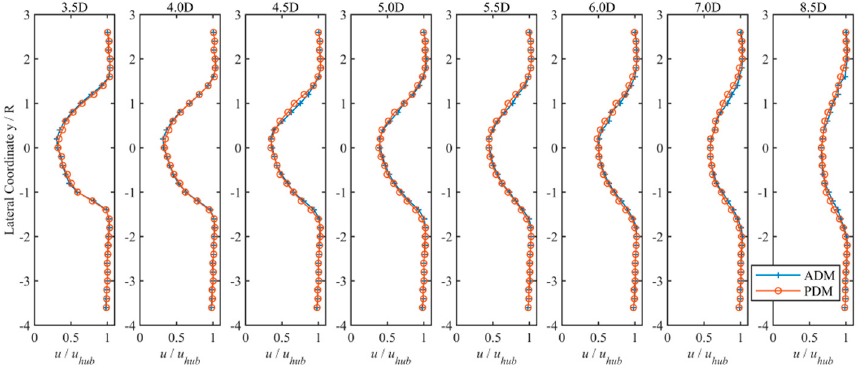
Figure 8. Mean wake velocity distributions in the ADM and PDM at λ = 4 in the UIF wind tunnel.